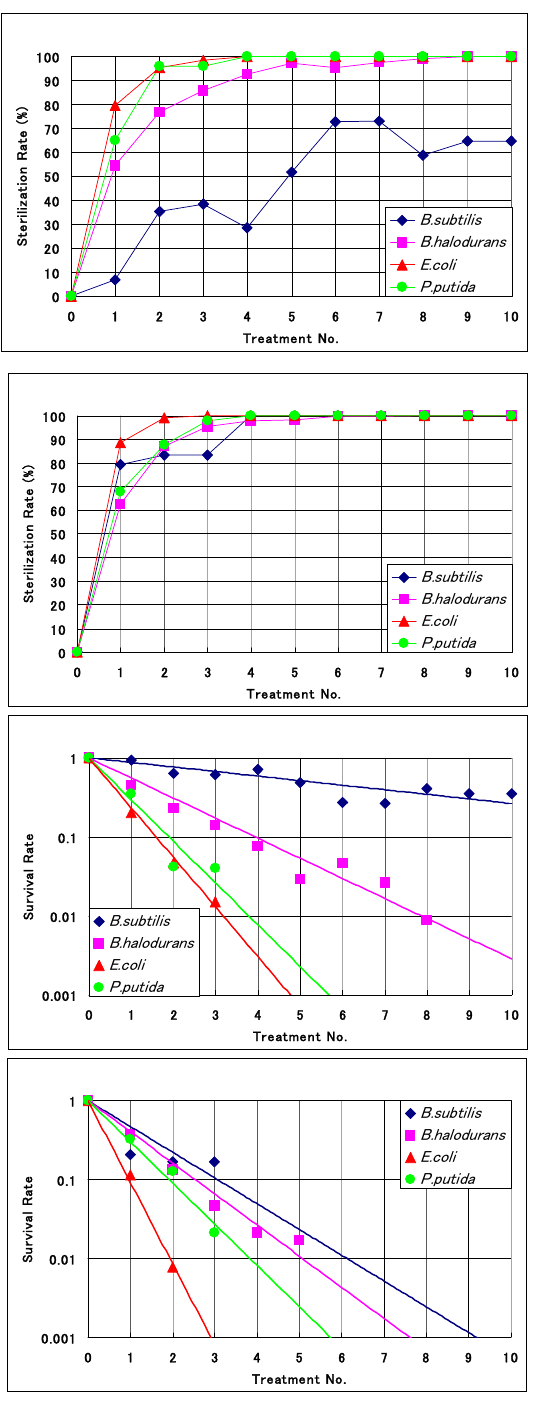
Fig.14 Survival rate of various bacteria at V=353.7 m/s, σ =0.037, and P=80